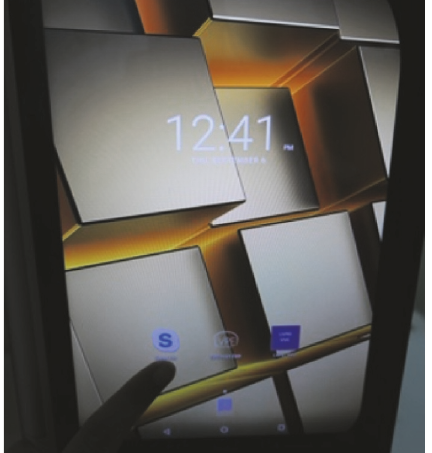
Figure 13: Use of Skype Lite on the tablet.